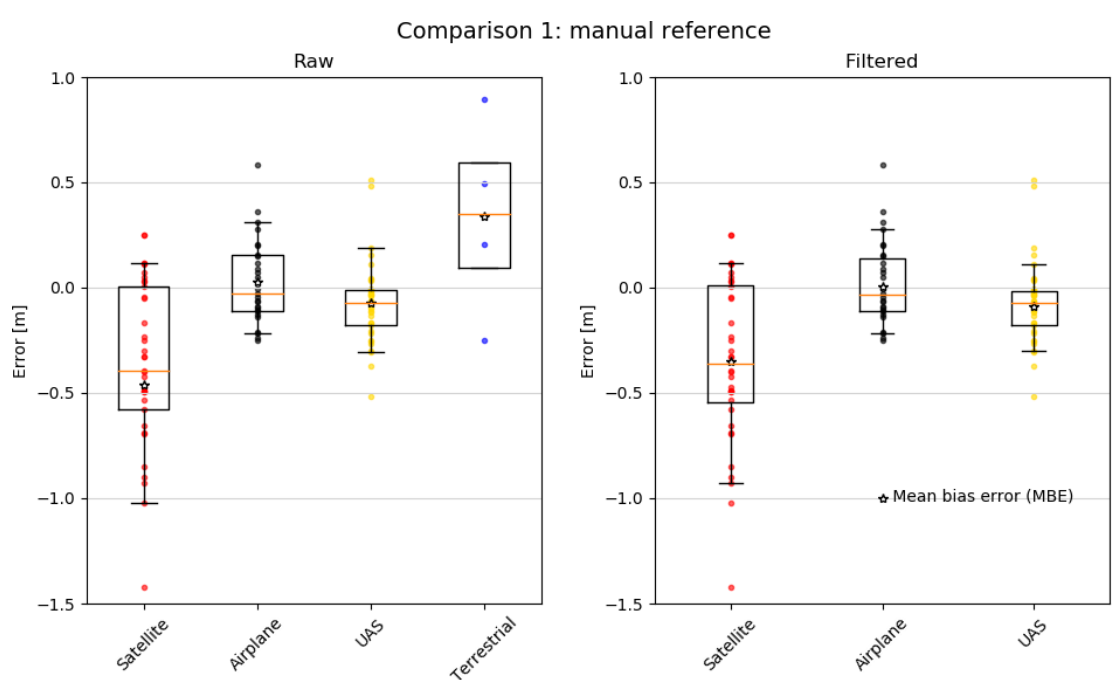
Figure 7. Box plots with single-value plots for comparison 1. The orange line depicts the median, the star the mean bias error (MBE). The 25th and 75th quartiles are represented by the boxes and the 5th and 95th percentiles by the whiskers. The left box plot shows the raw data and the right box plot the data where plus or minus 2 SDs are removed. Because of the small sample size of the terrestrial data, applying such a threshold does not have statistical relevance, and therefore the terrestrial data are not shown in the right box plot anymore. To better illustrate the distribution of the error, we calculated single-value plots and included them into the box plots. Note the single large outlier ( − 4 . 47m) from the satellite data is not shown in the raw data to improve